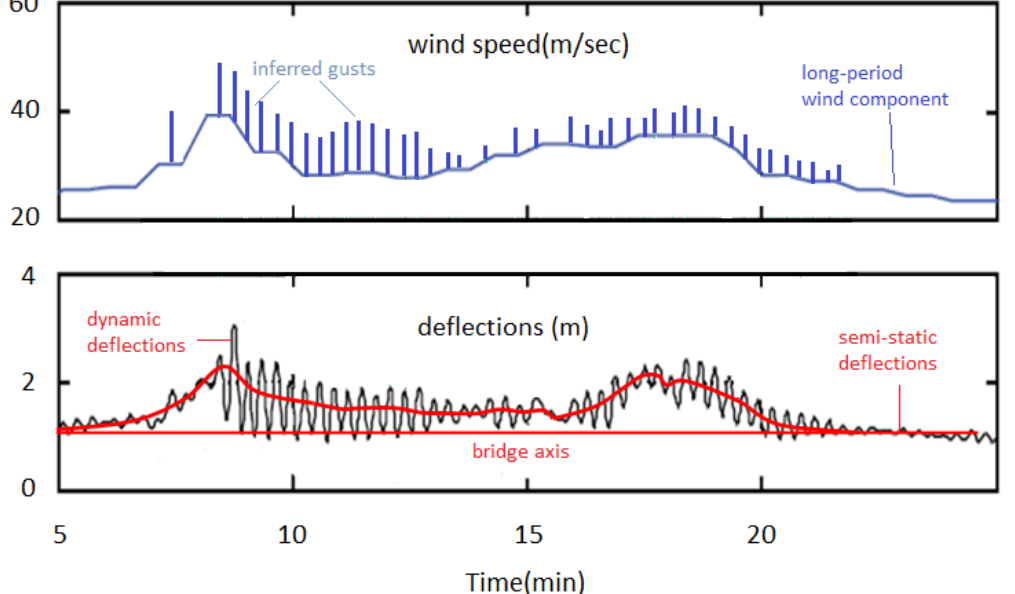
Figure 9. Wind excitation and lateral deflections of the Humber Bridge, UK, based on data of [5]. The time series of deflections imply a combination of semi-static deflections (due to the long-period component of wind), on which are superimposed dynamic deflections (with similar order of magnitude, amplitude up to 2 m) generated by gusts, schematically indicated in the top figure. A similar causative relationship between wind components and deflections is assumed for the Kanellopoulos Bridge as well.